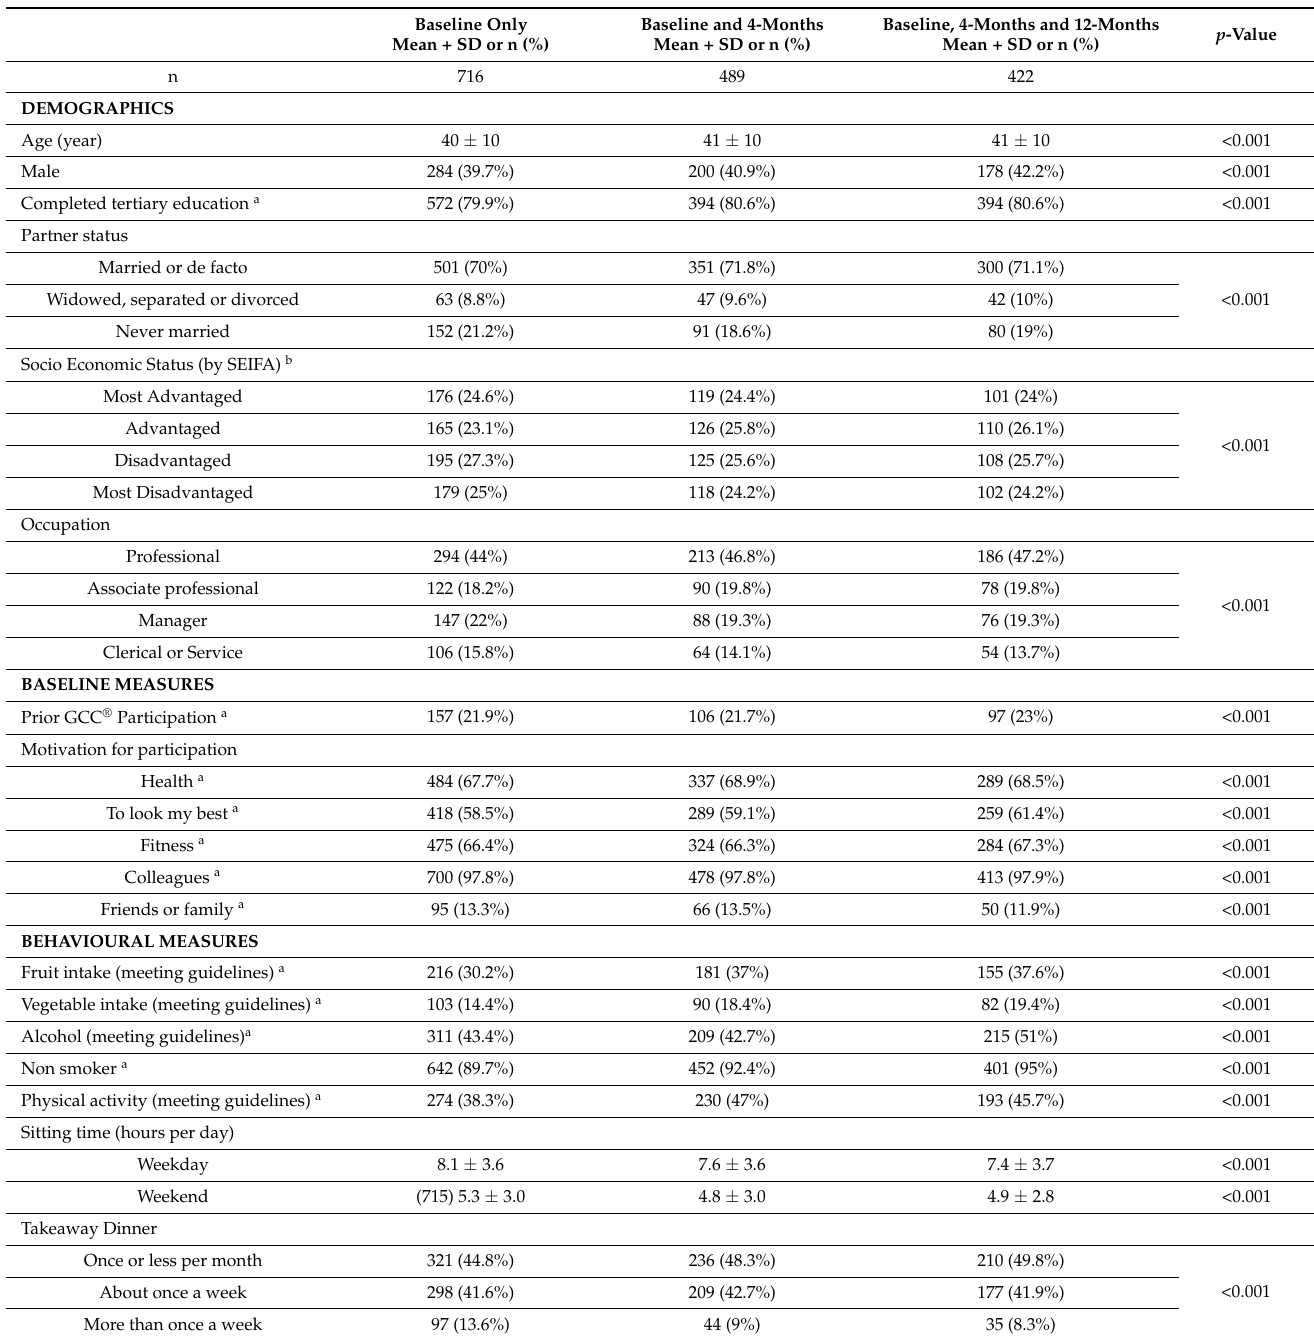
Table A2. Comparison of baseline participant characteristics between participants who did and did not attend the 4-month and 12-month follow-up